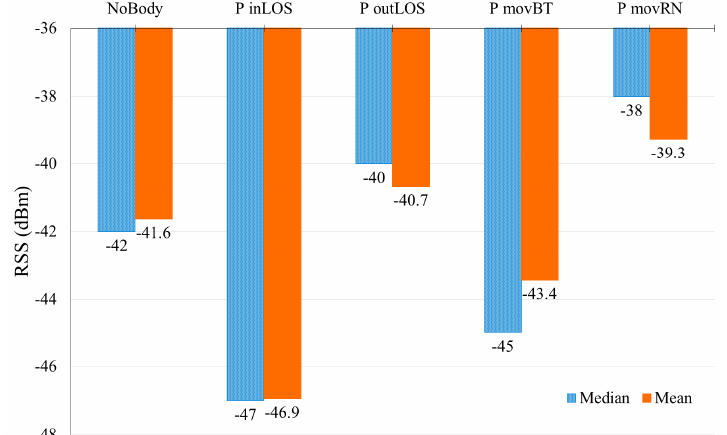
Figure 19. PPE in HLOS RSS centroid values.